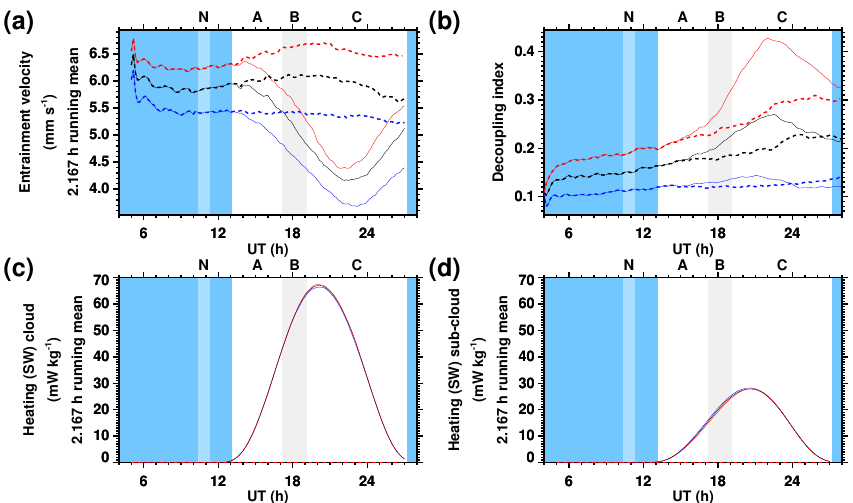
Figure 7. Wind speed and the diurnal cycle. Time series from simulations M − (blue), M 0 (black), M + (red), solid curves, and from simulations M − (blue), M 0 (black), M + (red), dashed curves. A low-pass (running mean) filter was applied where indicated to reduce dark dark dark